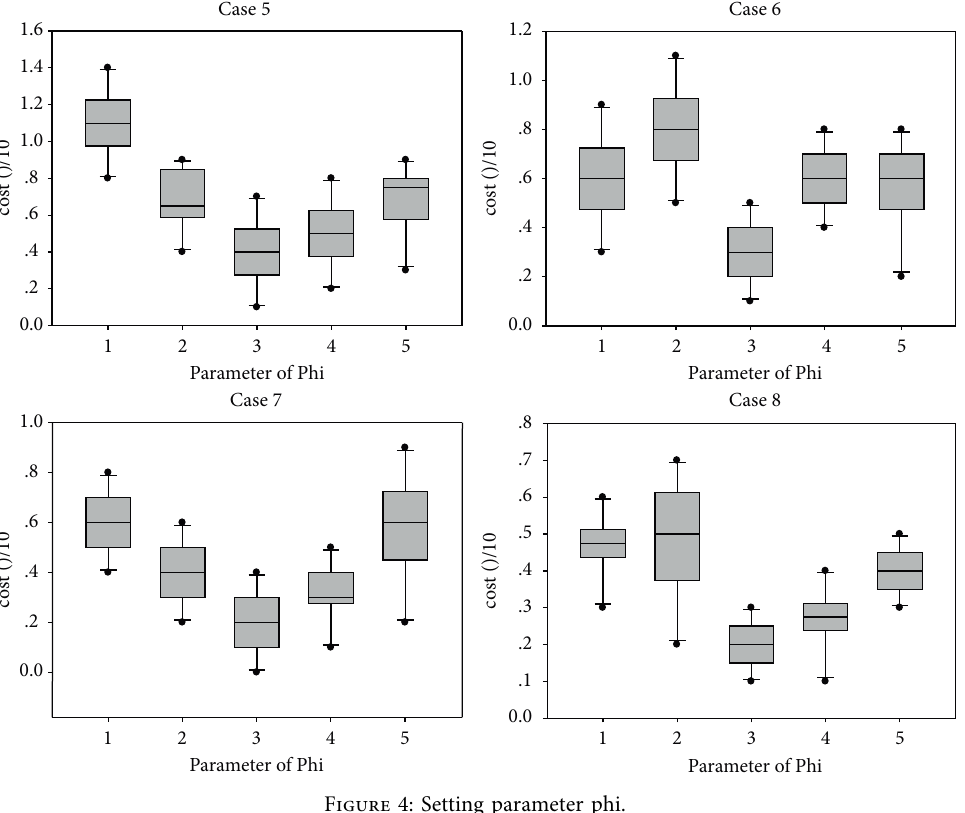
Figure 4: Setting parameter phi.